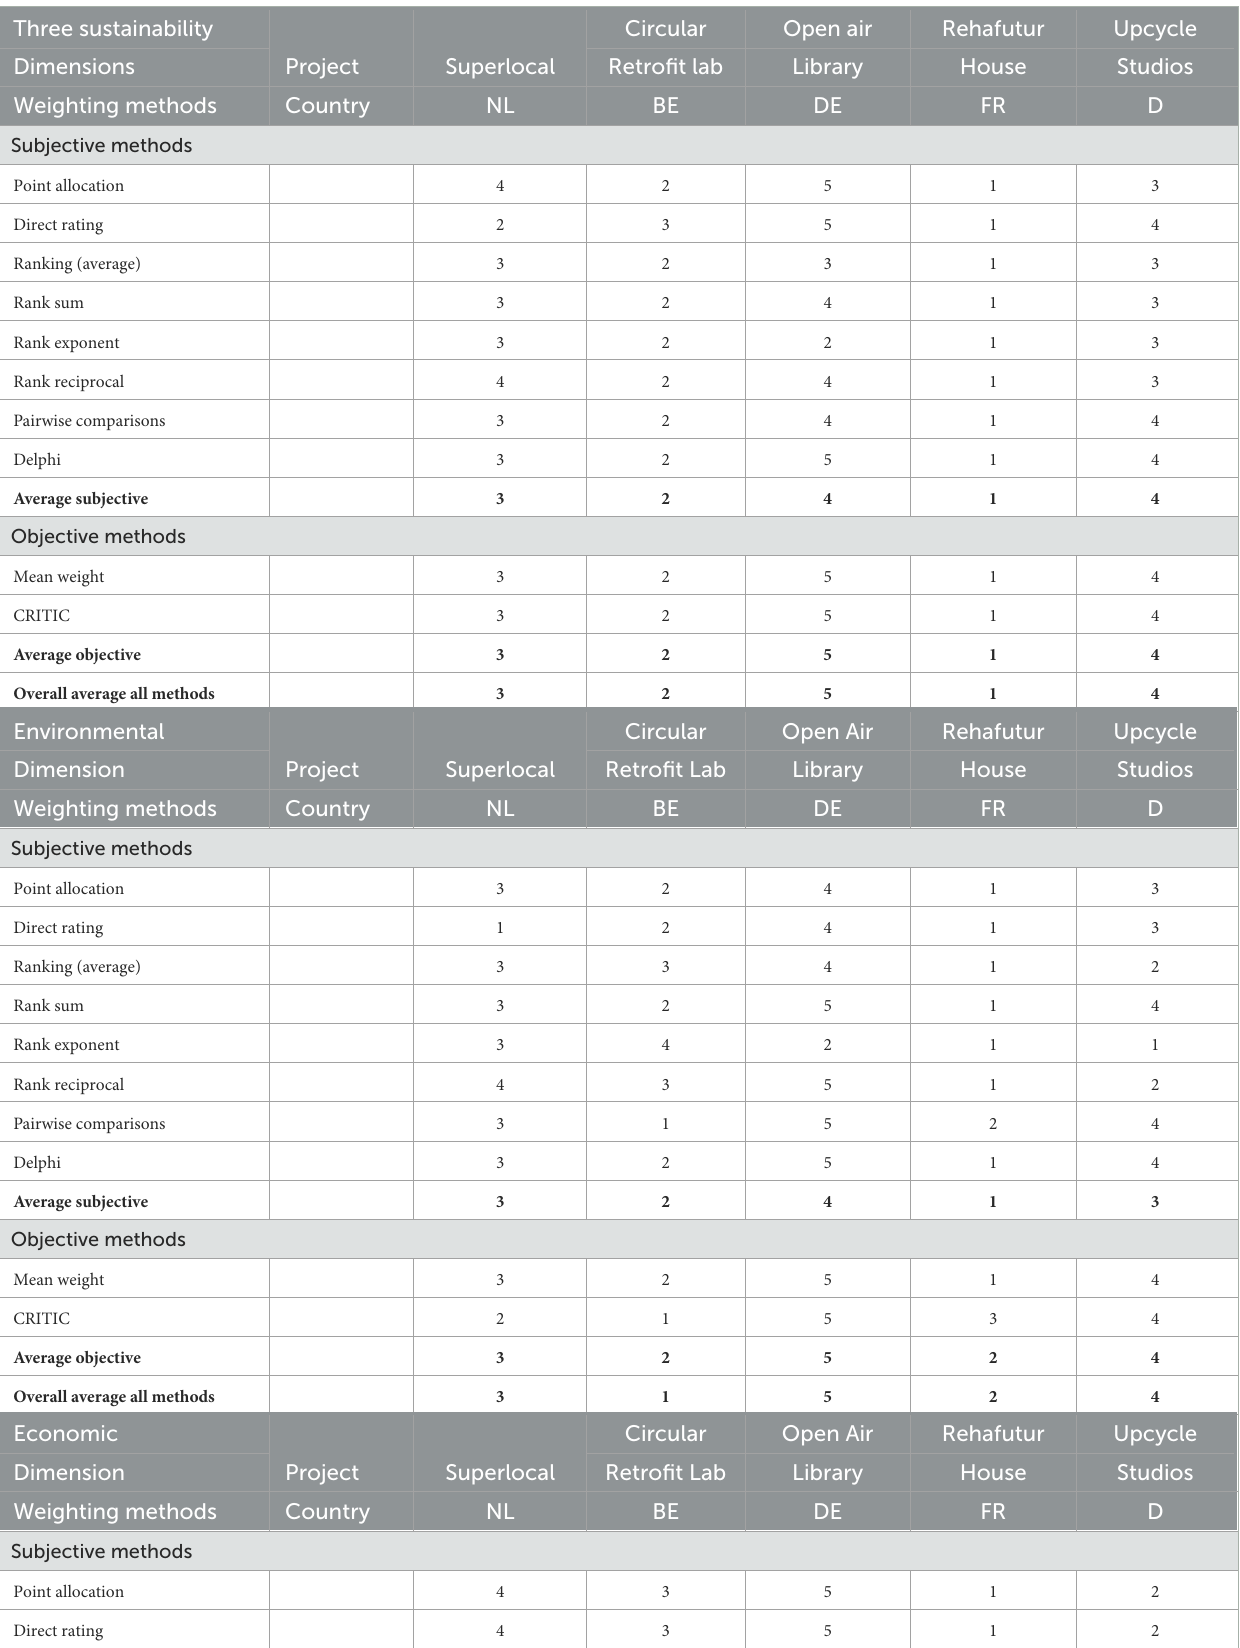
TABLE 6 Comparison of project rankings per weighting method. Three sustainability Circular Open air Rehafutur Upcycle Dimensions Project